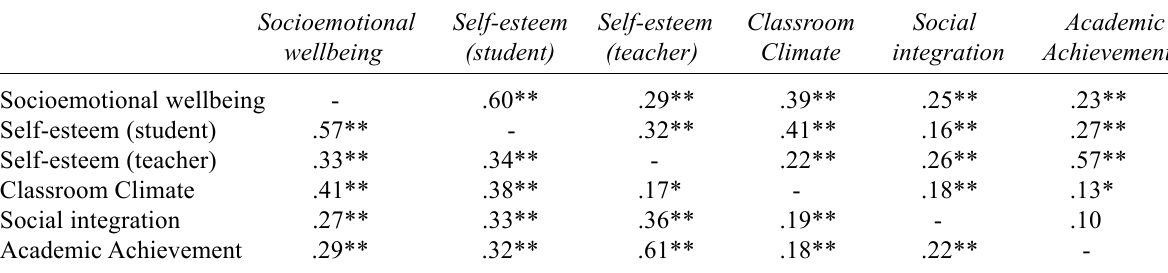
Hierarchical Linear Modeling